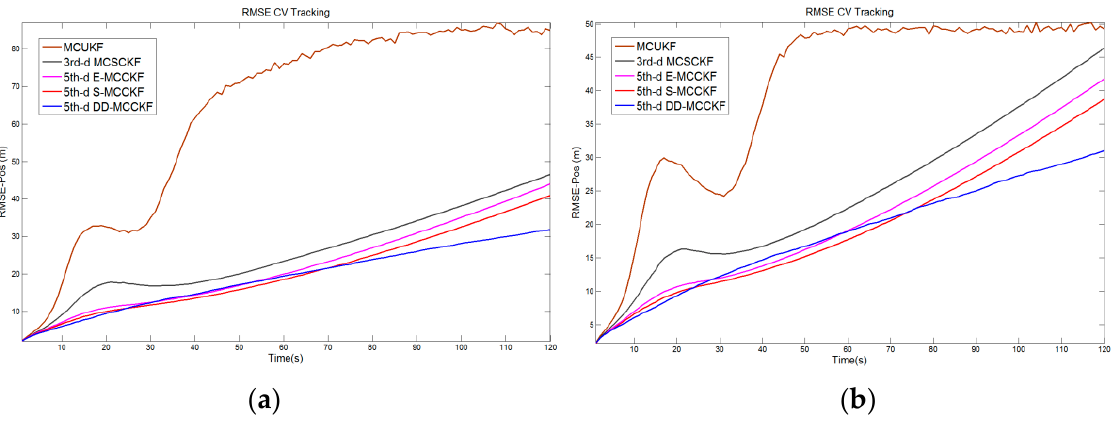
Figure 5. Position RMSEs of robust target-tracking algorithms under non-Gaussian noise conditions (( a ) is the result under Equation (61) and ( b ) is the result under Equation (62)).